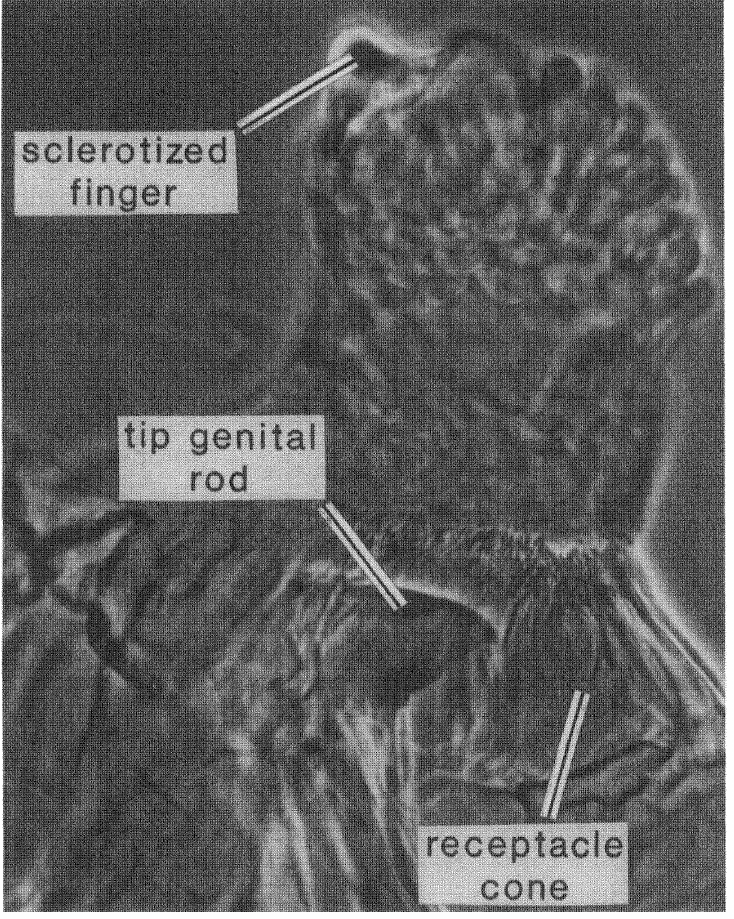
Fig. 2. The ventral receptacle of a female and the sclerotized portion of the vagi- nal wall (receptacle cone) near its opening, into which projects the tip of the male’s genital rod. There are many finger-like projections of the distal portion of the recep- tacle, and a single sclerotized projection at the